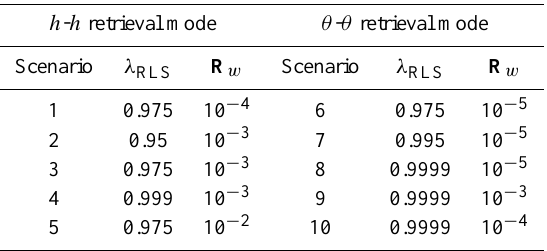
Table 3. Scenarios for assessing the effect of the artificial noise vari- ance in parameter state space equations.